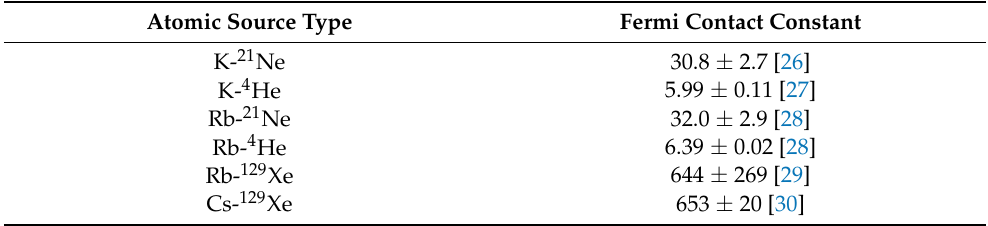
Table 1. Contact constants of Fermi interactions between different atomic sources.